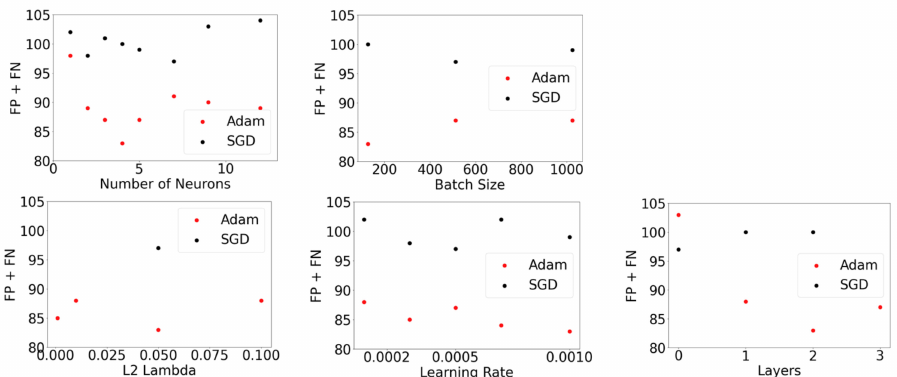
Figure 6. Model performance using the SGD optimizer (black markers) and Adam optimizer (red markers) in terms of FP + FN measured on the test dataset. Top panel: number of neurons and batch size; bottom panel: L2 lambda, learning rate and